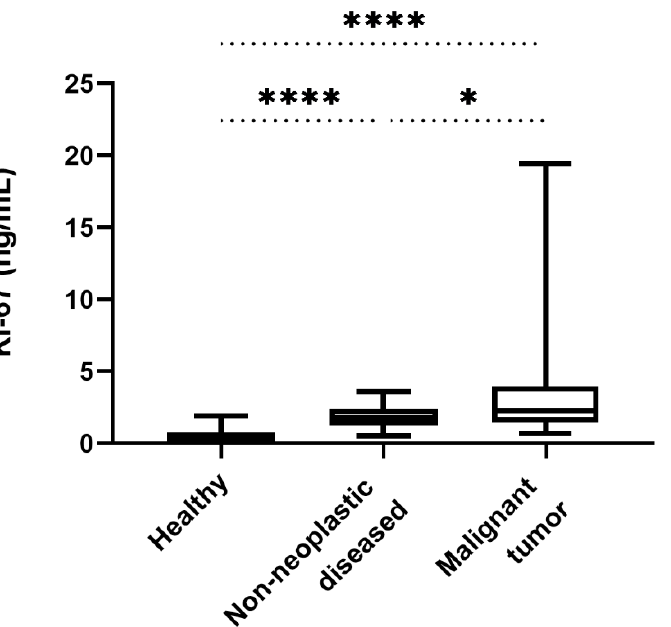
Figure 2. Comparison of the serum Ki-67 concentrations in healthy dogs, dogs with non-neoplastic diseases, and dogs with malignant tumours. Concentrations between healthy dogs and those suffering from non-neoplastic diseases differed significantly ( p < 0.0001). The dogs with malignant tumours had significantly higher Ki-67 concentrations than healthy dogs ( p < 0.0001) and those with non-neoplastic diseases ( p = 0.027). (*) p < 0.05; (****) p < 0.0001.